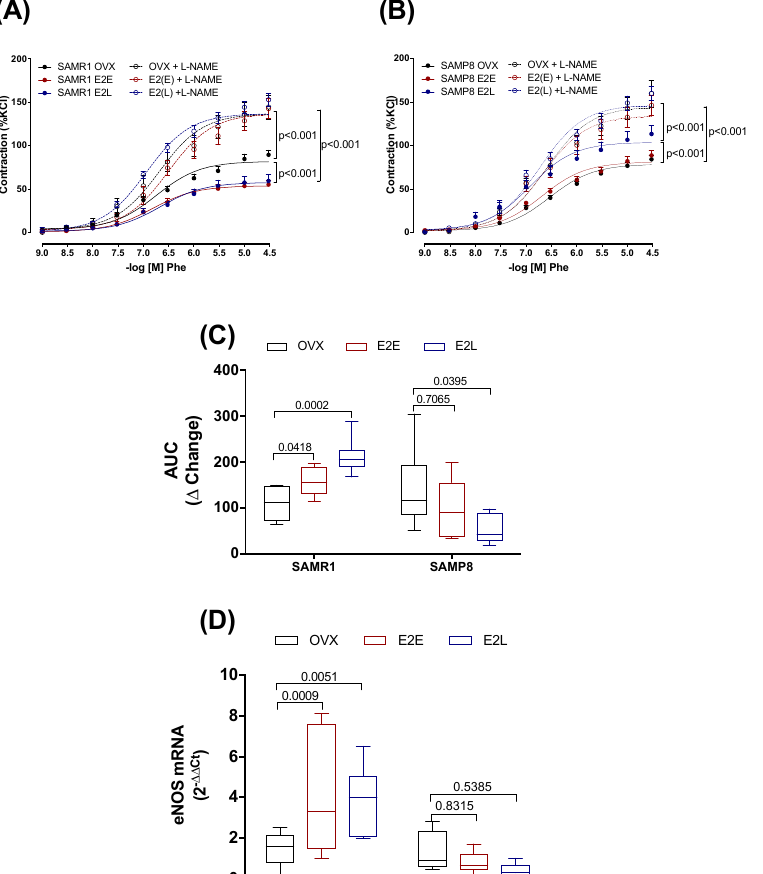
Figure 2. Role of NO in phenylephrine-induced contractions. Concentration–response curves to phenylephrine (Phe) in endothelium-intact common carotid artery from SAMR1 ( A ) and SAMP8 ( B ). Arteries were isolated from untreated ovariectomized mice (OVX), or OVX treated with early-onset of 17 β -estradiol treatment (E 2 E) or late-onset 17 β -estradiol treatment (E 2 L). Curves were obtained in the absence or the presence of L-NAME (10 − 4 M). The contribution of NO to Phe contraction is expressed as the change ( ∆ Change) in the area under the curve in L-NAME treated arteries relative to untreated arteries ( C ). mRNA levels of eNOS ( D ) normalized by β -actin mRNA and relative to the expression of untreated OVX mice. Each point represents the mean ± SEM from 8–17 independent experiments. The extra sum-of-squares F determined di ff erences in the fit of concentration–response curves. One-way ANOVA analyzed the dependence of data on the onset of estrogen therapy (none, early or late) in SAMR1 or SAMP8 with Bonferroni’s post-test. p -values and comparisons are expressed next to the curves and on top of bar graphs. Significance is considered when p <